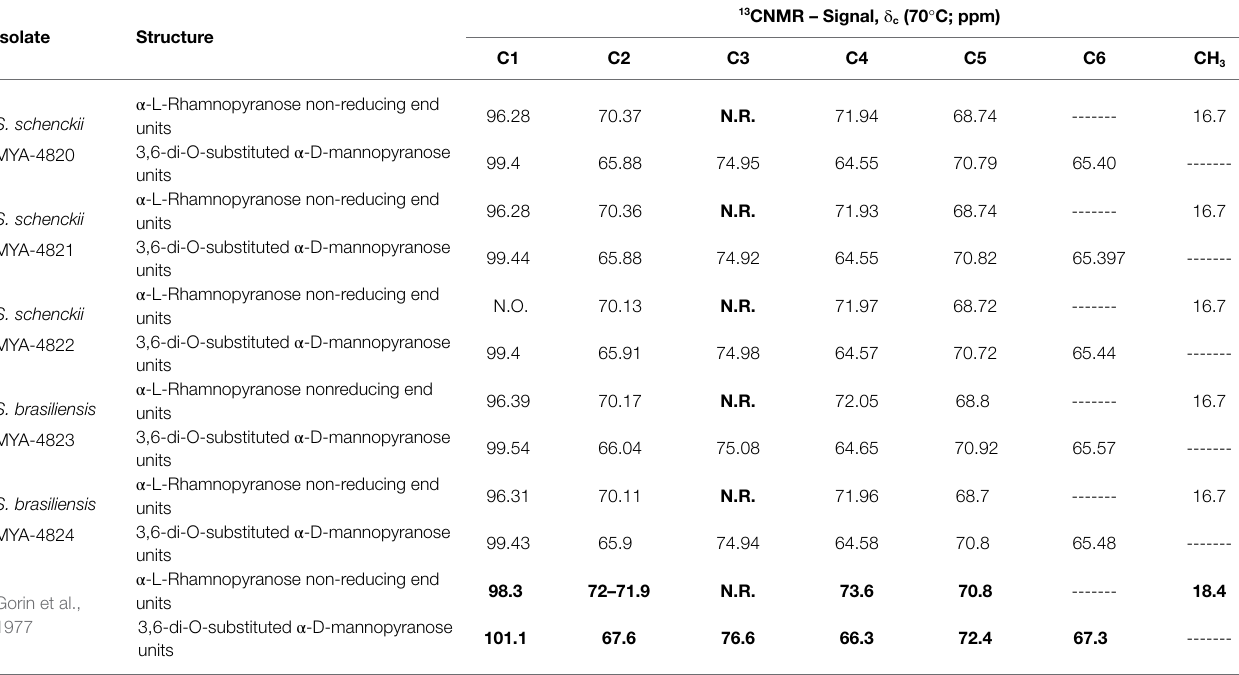
TABLE 2 | 13 C-NMR signals of S. schenckii and S. brasiliensis rhamnomannan, yeast phase.